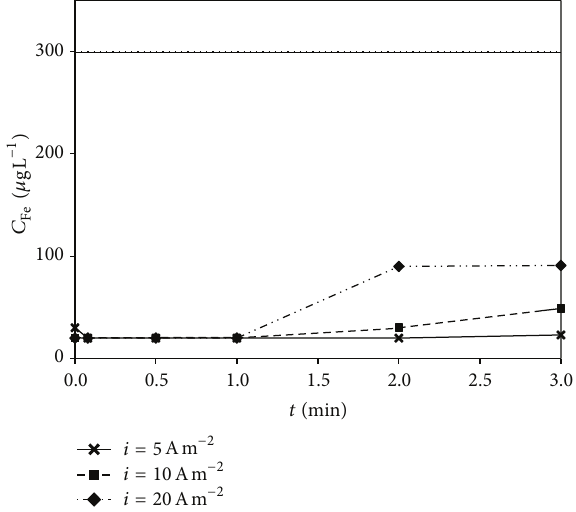
Figure 5: Variation of residual Fe concentration as a function of time for treatments carried out with a continuous flow of 0.25 Lmin −1 and applied current densities of 5, 10, and 20 Am −2